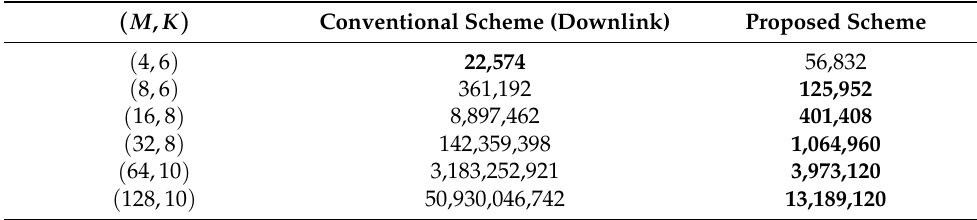
Table 2. Computational complexities for the various ( M , K ) pairs in the downlink.